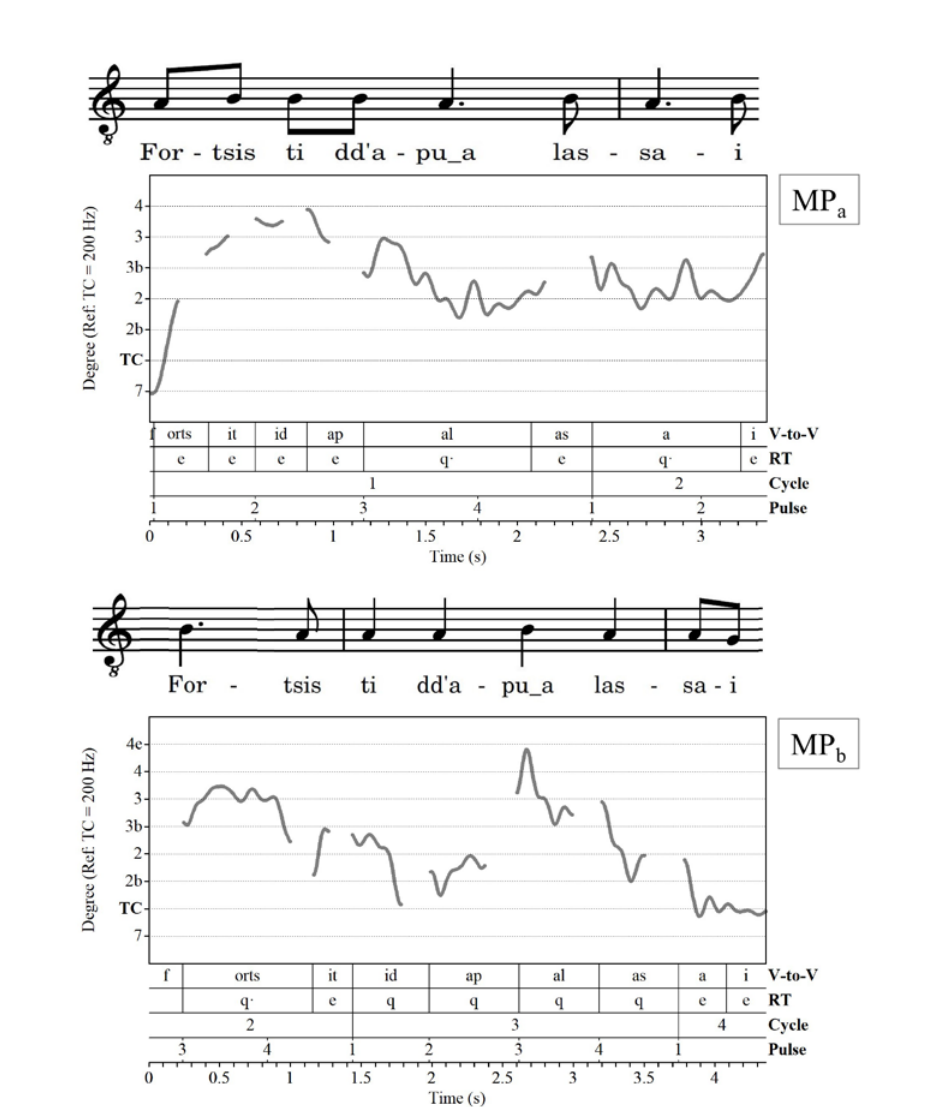
Figure 7: An illustration of MPa (top panel) and MPb (bottom panel). Both MP's are taken from the first line of Efisio Caddeo’s second APF. Each MP is represented by both a standard musical score, including the lyrics, and the corresponding Praat pitch contour. The labels on the y-axis relevant to the pitch graph indicate the tonal center and distance from it expressed in terms of the standard music system (in particular: b = minor interval, e = exceeding interval; examples: 2b = minor second, 2 = major second, 4e = exceeding fourth). The four-tier annotation under the pitch profiles show the transcription of the V-to-V intervals together with the relevant rhythmic values and the 4-pulse cycles wherein each melodic phrase is